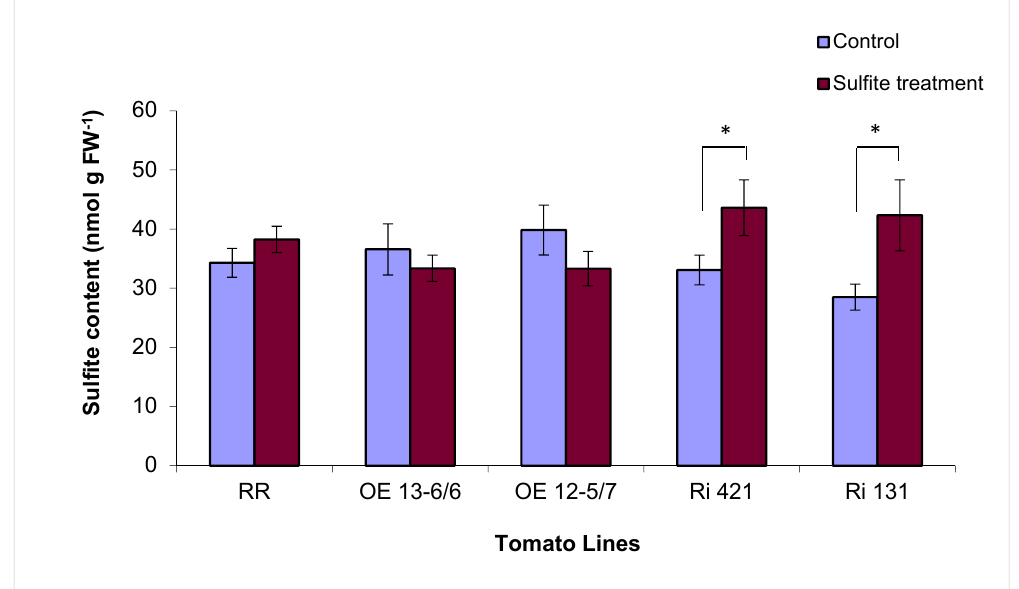
Figure 11. Pericarp sulfite content after sulfite dipping treatment. Fruits of wild type (RR), SO OE (OE 13-6/6 and OE 12-5/7), and SO Ri (Ri 421 and Ri 131) lines were dipped in 200 mM Na 2 SO 3 for two hours, subsequently kept at room temperature for 24 h and sampled. Fruits dipped in water served as a control. The values are means ± SE ( n = 4–6). Asterisks indicate significant differences at p < 0.05 between the treatments within the tomato lines.